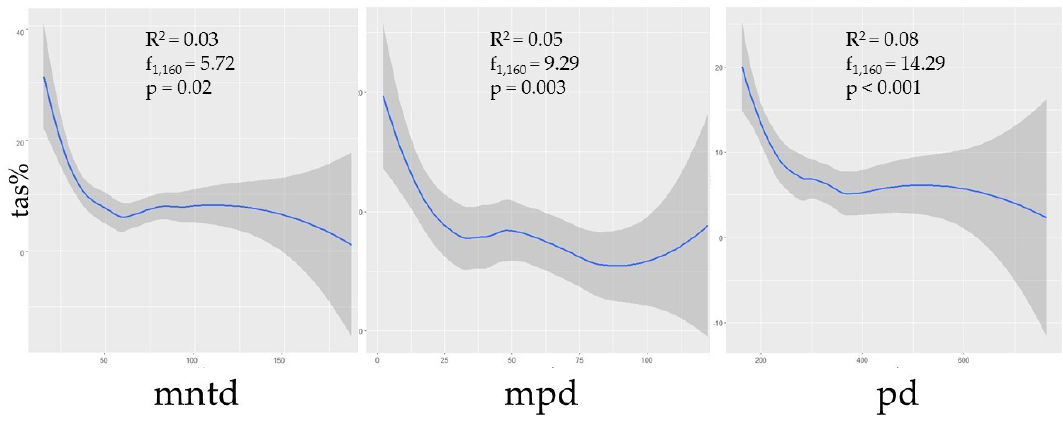
Figure 2. The curveplots show the relationship of total assemblage seroprevalence (TAS) against three phylogenetic indices: Mean nearest taxon distance (MNTD), mean pairwise distance (MPD), and phylogenetic diversity (PD). Confidence intervals (95%) are shown in grey. Data are shown at the global scale.